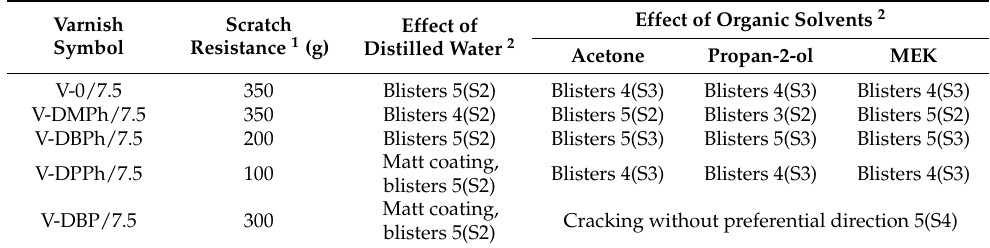
Table 2. Scratch, water, and solvent resistance of the UV-cured varnish